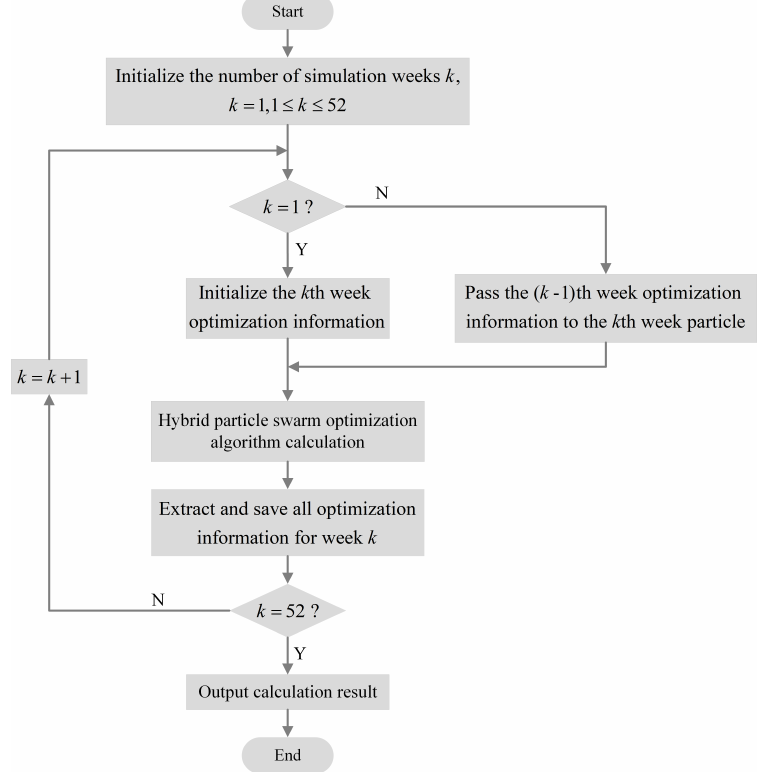
Figure 3. The flowchart of optimization calculation